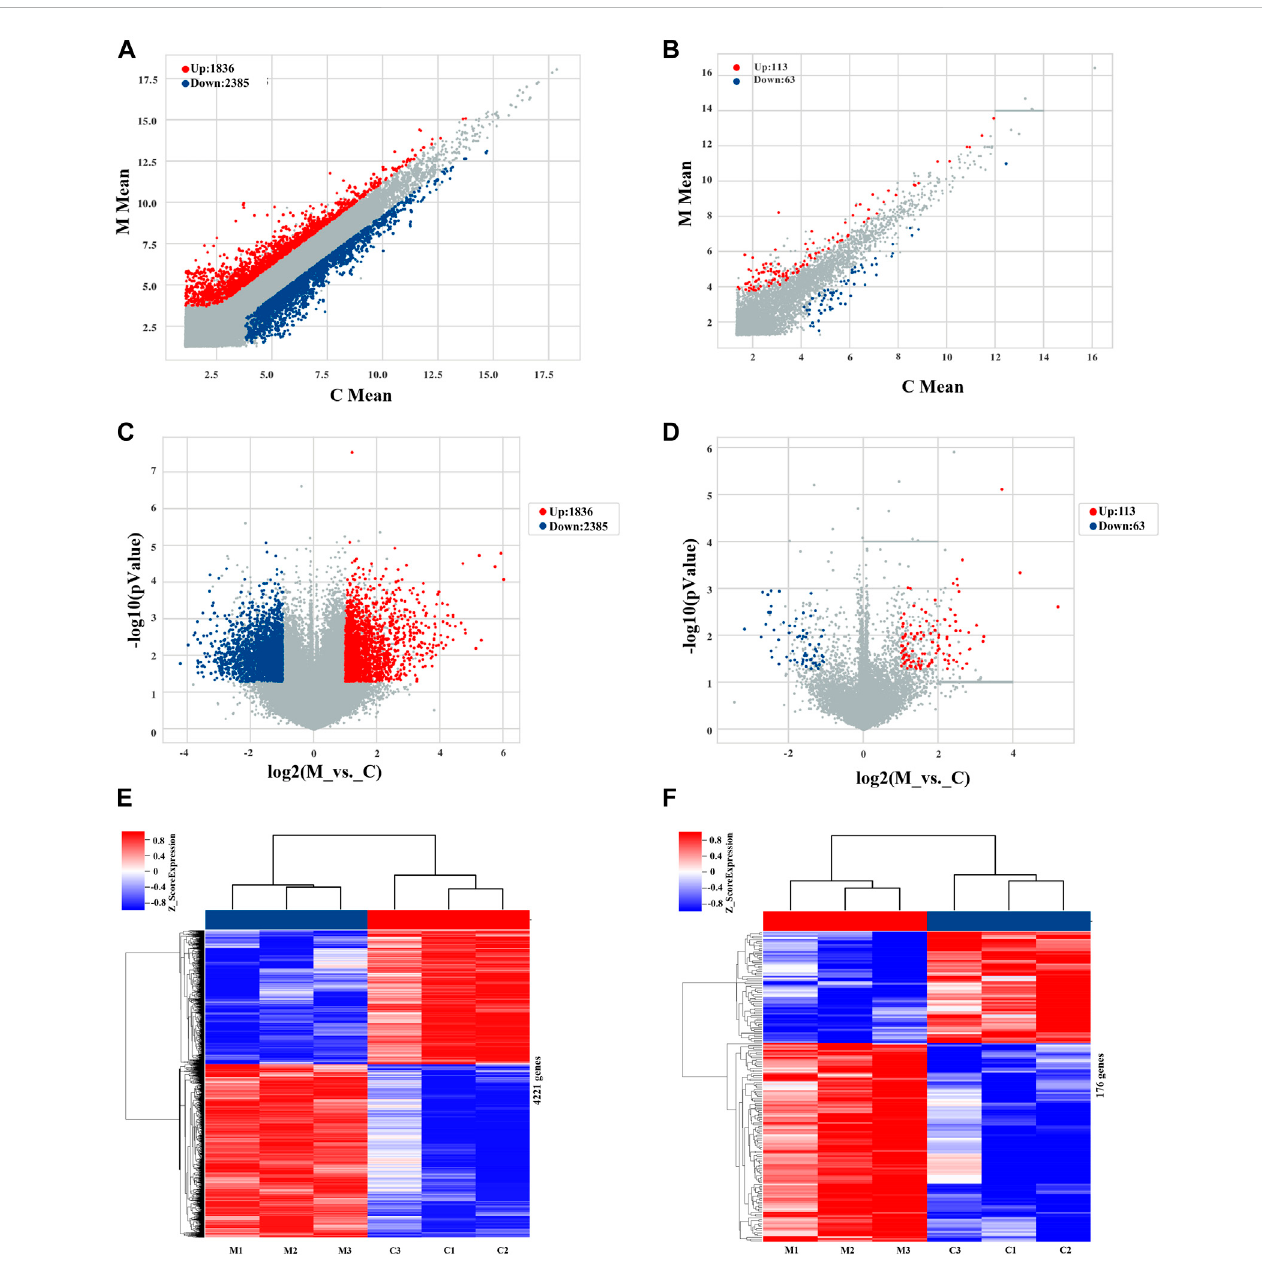
FIGURE 3 Pro fi les of lncRNAs and mRNAs differentially expressed during early hepatotoxicity induced by MCT. (A,B) Scatter plots of differentially and non- differentially expressed mRNAs and lncRNAs, respectively. (C,D) Volcano maps of differentially and non-differentially expressed mRNAs and lncRNAs, respectively. Each point on the graph corresponds to one mRNA/lncRNA; the abscissa corresponds to its expression in the control group, and the ordinate corresponds to its expression in the MCT treatment group. (E,F) Cluster heat maps of mRNAs and lncRNAs, respectively, in the control and MCT-treated groups. Each row corresponds to a differentially expressed mRNA/lncRNA, and each column corresponds to a sample. Color indicates the relative change to the corresponding mRNA/lncRNA in each sample: red corresponds to high expression, blue corresponds to low expression, and gray (in volcano and scatter plots) represents an mRNA/lncRNA that does not meet the corresponding threshold. C, control group; M, monocrotaline-treated